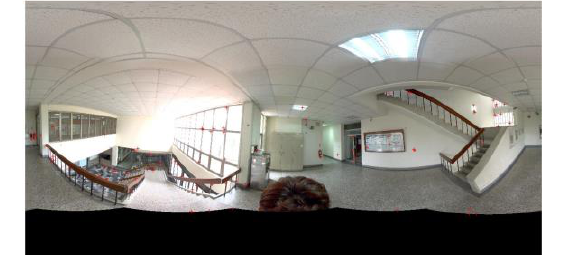
Figure 13(a). Query image of corresponding pair